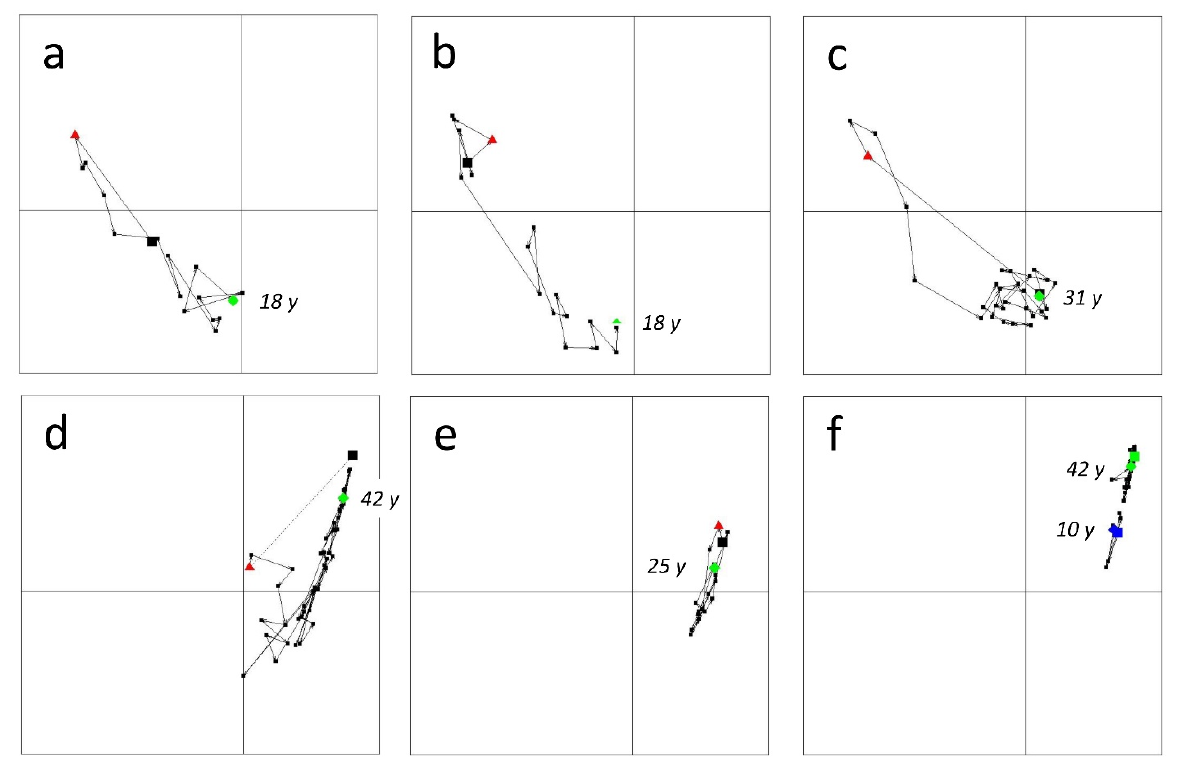
Figure A5. Before/after change in species richness observed in six vegetation classes belonging to a grassland-to-woodland gradient (A to F), in unburned surveys (black curve) and burned surveys the first year (red) and the eighth year (green) after a fire.